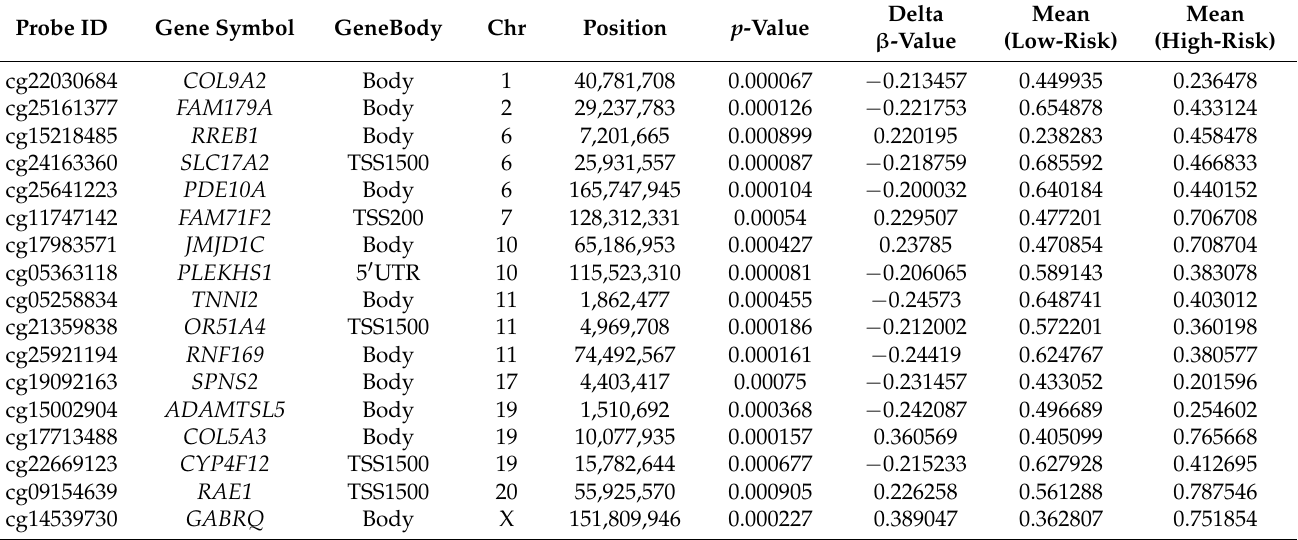
Table 2. Differentially methylated genes between aggressive (high-risk) and indolent (low-risk) prostate tumors in Puerto Rican men with prostate